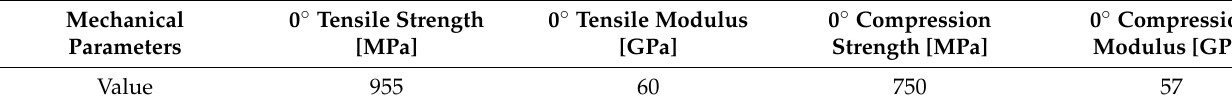
Table 2. Cured Prepreg Mechanical Properties (HexPly ® M79, 2014).